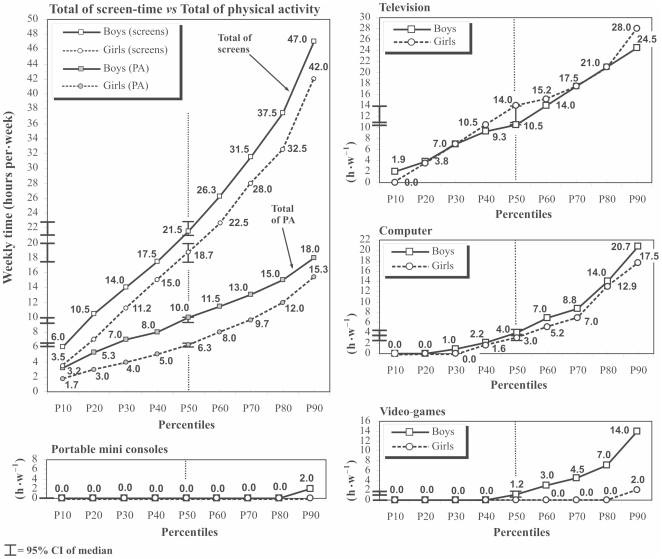
Percentiles of time dedicated to television, computer, video-game, portable mini consoles and total of screen-related behaviors among adolescents participants.